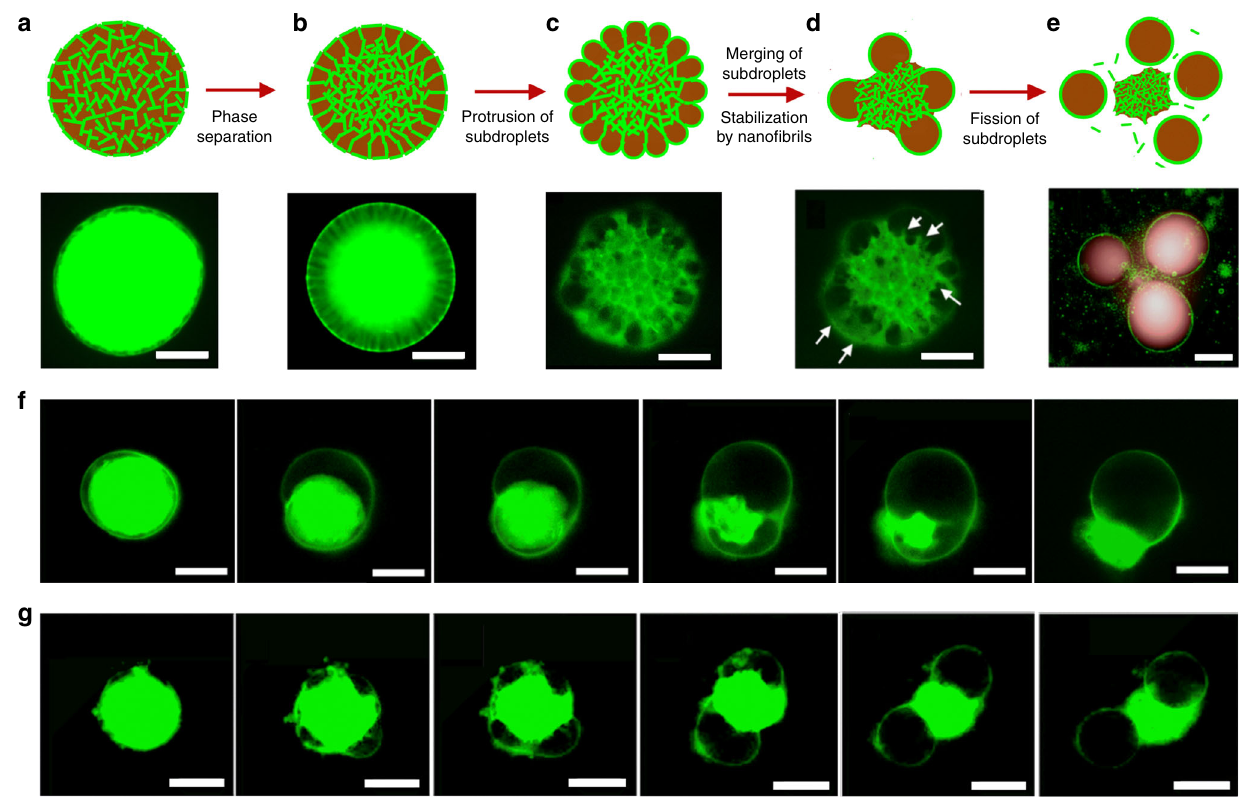
Fig. 2 Mechanism of budding-like division of w/w emulsion droplets mediated by protein nano fi brils. a – e Schematic diagram and fl uorescence microscope images describing the mechanistic steps in the budding-like division of w/w droplets. The fi bril network (stained green) contracts and phase-separates from the remaining liquid phase through a dewetting transition. In this transition, the as-formed protrusions coalesce (as pinpointed by the white arrows) until a suf fi cient amount of fi brils adsorbs at the w/w interface to stabilize daughter droplets. Complete fi ssion of dextran-rich subdroplets (faked red color) is observed after total decomposition of the fi bril networks in the PEG-rich continuous phase. Scale bars, 100 μ m. Fluorescence microscope images showing f single division ( C fi bril = 0.5 wt%) and g multiple division ( C fi bril = 1.0 wt%) of w/w droplets preloaded with protein nano fi brils and 8% dextran. Scale bars, 200 μ m. The continuous phase consists of 8 wt% PEG dissolved in 10 mM